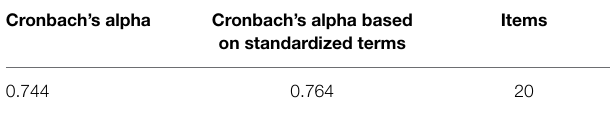
TABLE 1 | Reliability analysis